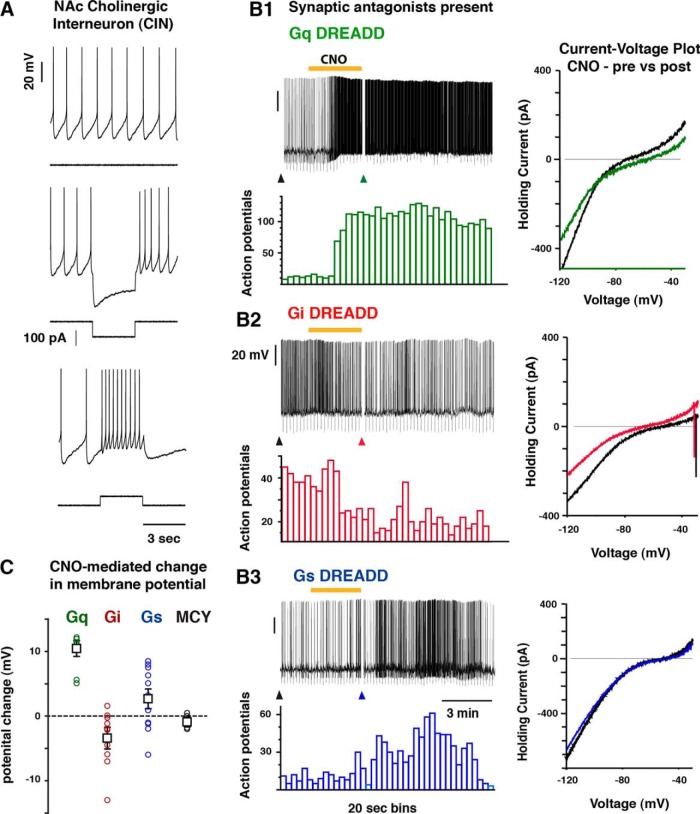
Designer receptor expression was sufficient for modulating CIN excitability in vitro. A, Recorded neurons were regular spiking and mostly spontaneously active at rest and showed signature CIN intrinsic currents. B, Bath application of 10 μM CNO reliably depolarized the membrane potential of neurons expression Gq-coupled (n = 10; B1, C) and Gs-coupled (n = 11; B3, C) designer receptors, whereas neurons expressing Gi-coupled (n = 9) receptors were inhibited (B2). Black arrowhead (left), baseline current ramp injection; colored arrow (right), post-CNO current ramp injection. C, Results summary for CNO-mediated response from left to right in Gq-expressing (green), Gi-expressing (red), Gs-expressing (blue), and MCY-only (black; n = 6) CINs plotted as the change in membrane potential. Synaptic antagonists (in μm) = CNQX 20, AP5 100, CGP-52432 10, gabazine 10.